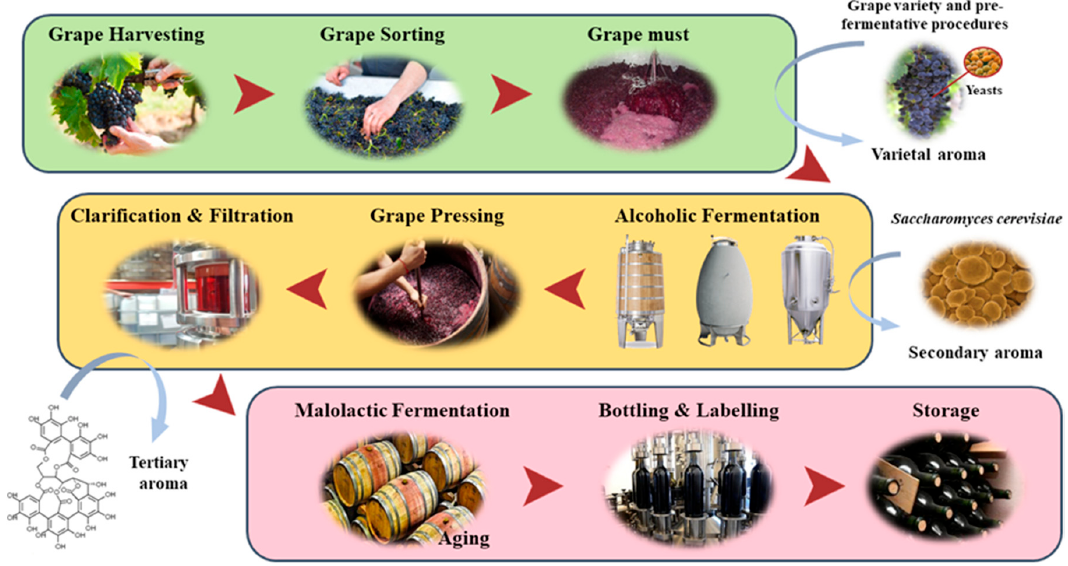
Figure 3. Production process of a red wine subjected to barrel aging. This process corresponds to the general winemaking process of red wines. In the case of white wines, the pressing step is carried out before alcoholic fermentation.